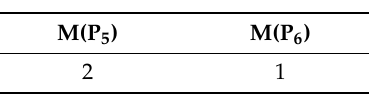
Table 10. Forbidden markings (P 5 P 6 ) of Example 3.